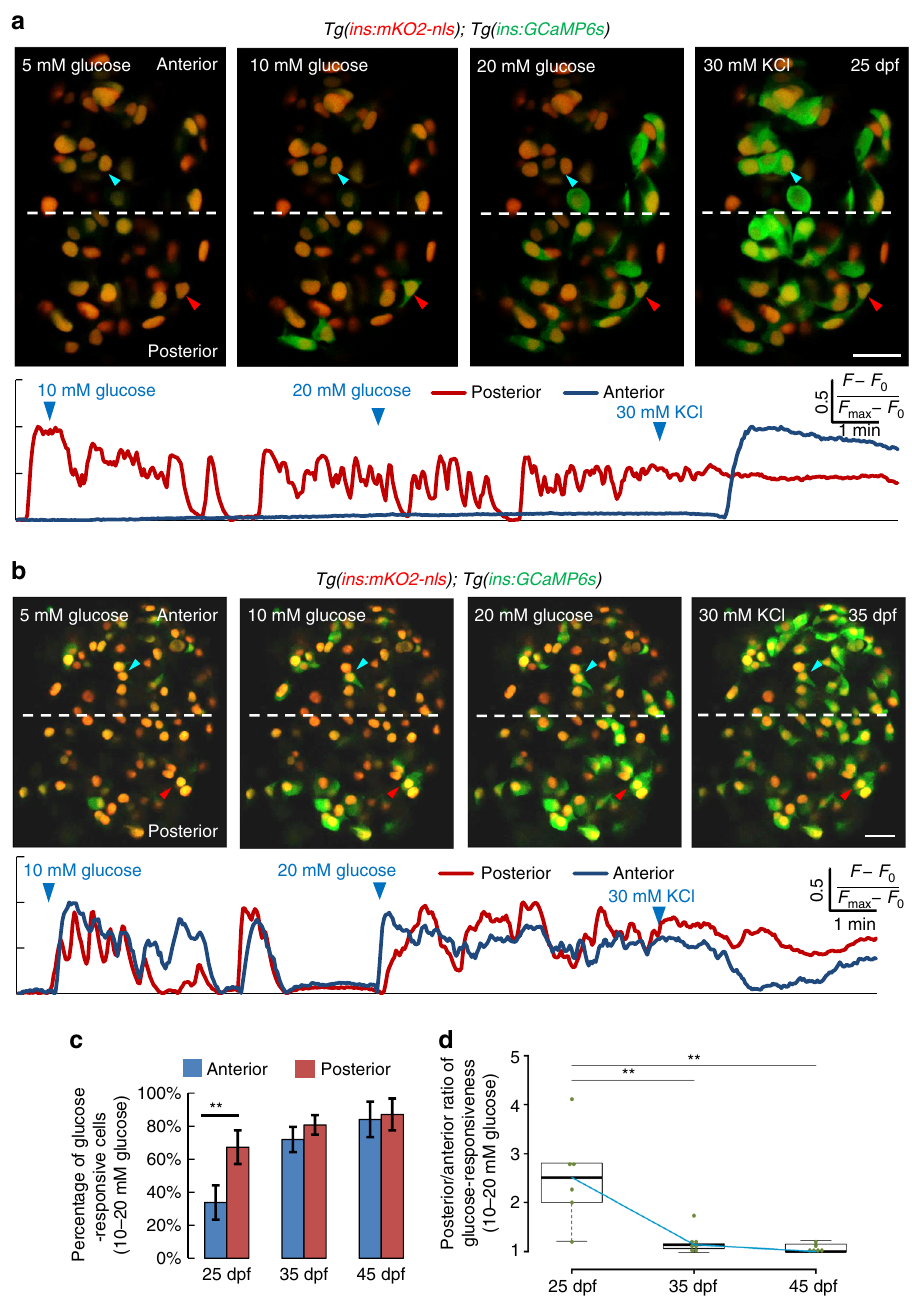
Fig. 4 The islet ’ s anterior and posterior cells exhibit temporal differences in glucose-responsiveness during post-embryonic development. a Top — ex vivo live imaging of islets from 25 dpf Tg(ins:GCaMP6s);Tg(ins:mKO2-nls) animals. Beta-cells ( red nuclei ) were stimulated with a glucose ramp consisting of sequential incubation with 5 (basal), 10, and 20 mM D -glucose, and depolarized via addition of 30 mM KCl. A beta-cell in the islet ’ s posterior regions ( red arrowhead ) exhibits increasing GCaMP6s- fl uorescence in response to glucose. The anterior cell ( blue arrowhead ) only responds after KCl addition. More beta-cells in the posterior region respond to glucose, as compared to the anterior. Bottom — trace of normalized GCaMP6s- fl uorescence intensity over time for each of the two cells indicated in the top panels (posterior cell — red trace ; anterior cell — blue trace ). b Top — ex vivo imaging of islets at 35 dpf as in a . Beta-cells in the islet ’ s anterior ( blue arrowhead ) and posterior regions ( red arrowhead ) exhibit increasing GCaMP6s fl uorescence in response to glucose. Bottom — trace of normalized GCaMP6s fl uorescence intensity for each of the two cells indicated in the top panels (posterior cell — red trace ; anterior cell — blue trace ). c Quanti fi cation showing the mean percentage of beta-cells that respond upon sequential stimulation with 10 and 20 mM glucose in the islet ’ s anterior and posterior halves. At 25 dpf, more beta-cells respond to glucose in the posterior half, as compared to the anterior (paired two-tailed t -test, ** p ≤ 0.01). At 35 and 45 dpf, both halves show similar percentage of glucose-responsive cells ( n 25dpf = 90 cells in the anterior and 121 cells in the posterior region from 6 islets; n 35dpf = 133 cells in the anterior and 162 cells in posterior region from 7 islets; n 45dpf = 159 cells in the anterior and 233 cells in posterior region from 6 islets). Error bars = S.E.M. d Tukey style boxplot showing the posterior/anterior ratio of glucose responsiveness at 25, 35, and 45 dpf. Blue line connects the medians at each stage. The differences in glucose responsiveness between the islet ’ s anterior and posterior regions diminish with increasing age, as the ratio is close to one at 45 dpf. (Kruskal – Wallis test, p -value = 0.0039; Wilcox test, ** p ≤ 0.01). Scale bars , 20 µ